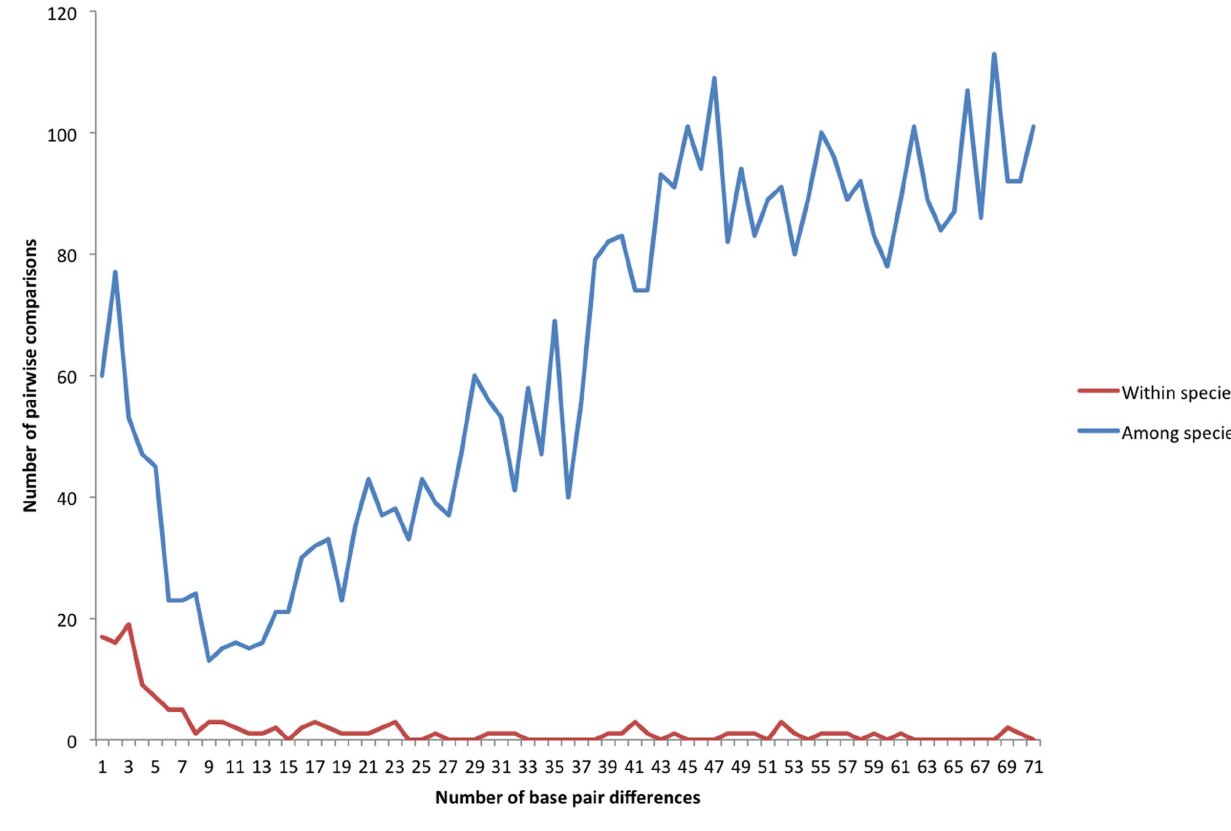
Figure 5. Plot of within- and between-species nucleotide divergence (bp).